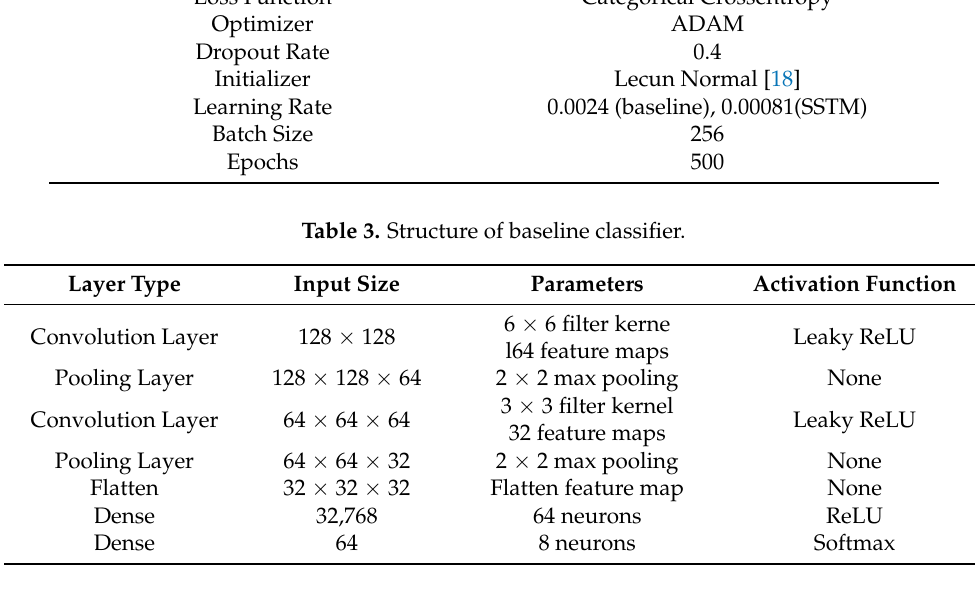
Table 2. Hyperparameters in signal spatial transformer module (SSTM)-based method training.